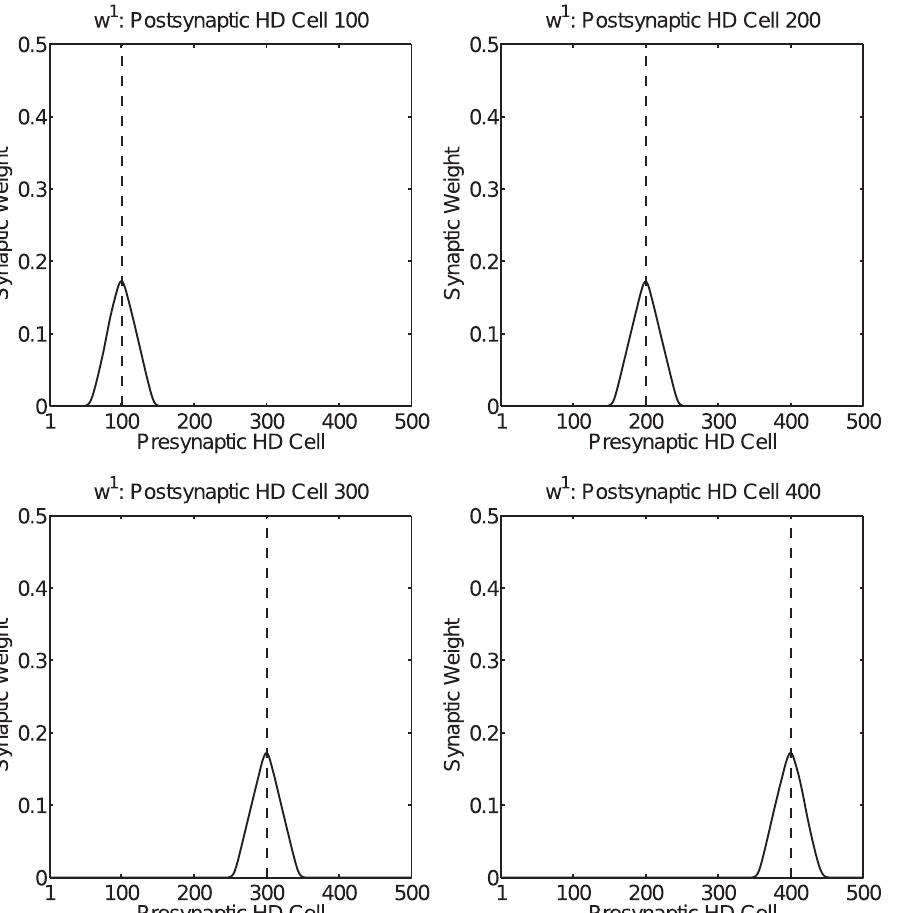
Figure 3. The recurrent synaptic weights w 1 within the network of Head Direction (HD) cells after training with the Hebbian associative learning rule (11) and weight normalization (13). These results are from a simulation with an axonal conduction delay of 100 ms, and a rotational velocity during training of 180 0 = sec (all other parameters are as given in Table 1). Each of the four plots shows the learned synaptic weights to a different postsynaptic HD cell from the other 500 presynaptic HD cells in the network. In the plots, the 500 presynaptic HD cells are arranged according to where they fire maximally in the head-direction space of the agent when visual input is available. For each plot, a dashed vertical line indicates the presynaptic HD cell with which the postsynaptic HD cell has maximal w 1 synaptic weight. In all plots, the synaptic weight profile is symmetric about the presynaptic HD cell with maximal synaptic strength, and this symmetry helps to support a stable packet of HD cell activity during testing in the absence of visual